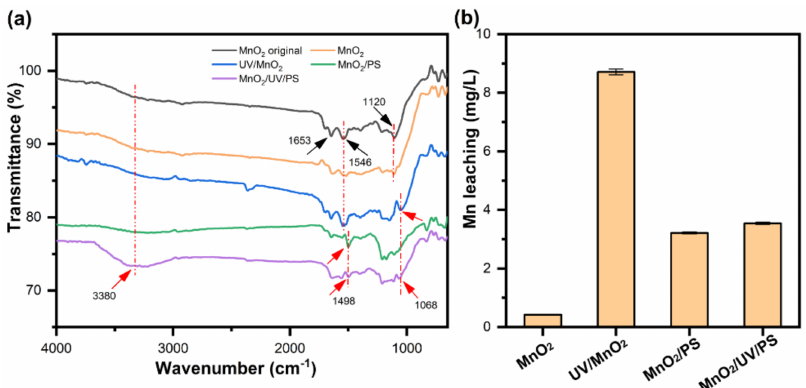
Figure 5. ATR-FTIR spectra of MnO 2 particles ( a ) and the concentration of Mn leaching ( b ) after 2 h treatment via MnO 2 only, UV/MnO 2 , MnO 2 /PS, and MnO 2 /UV/PS processes. The ICP-OES was further applied to identify Mn leaching after 2 h of treatment in MnO 2 , UV/MnO 2 , MnO 2 /PS, and MnO 2 /UV/PS processes (Figure 5b). Limited